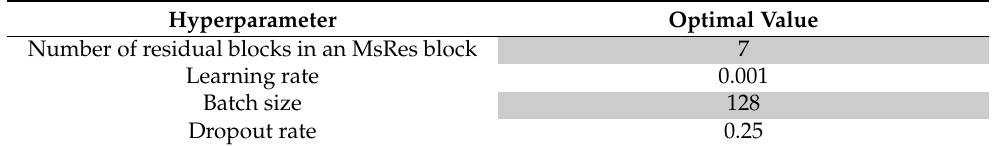
Table 6. The selected parameters of the